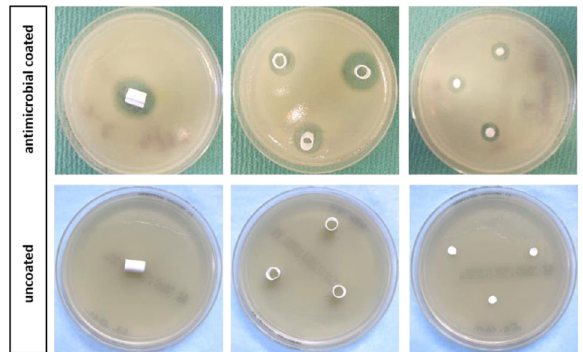
Fig. 1 Different geometrical types of vascular graft samples for zones of inhibition testing. Left and middle: cylindrical samples on Agar, incubated with S. aureus overnight. Right: circular stamped